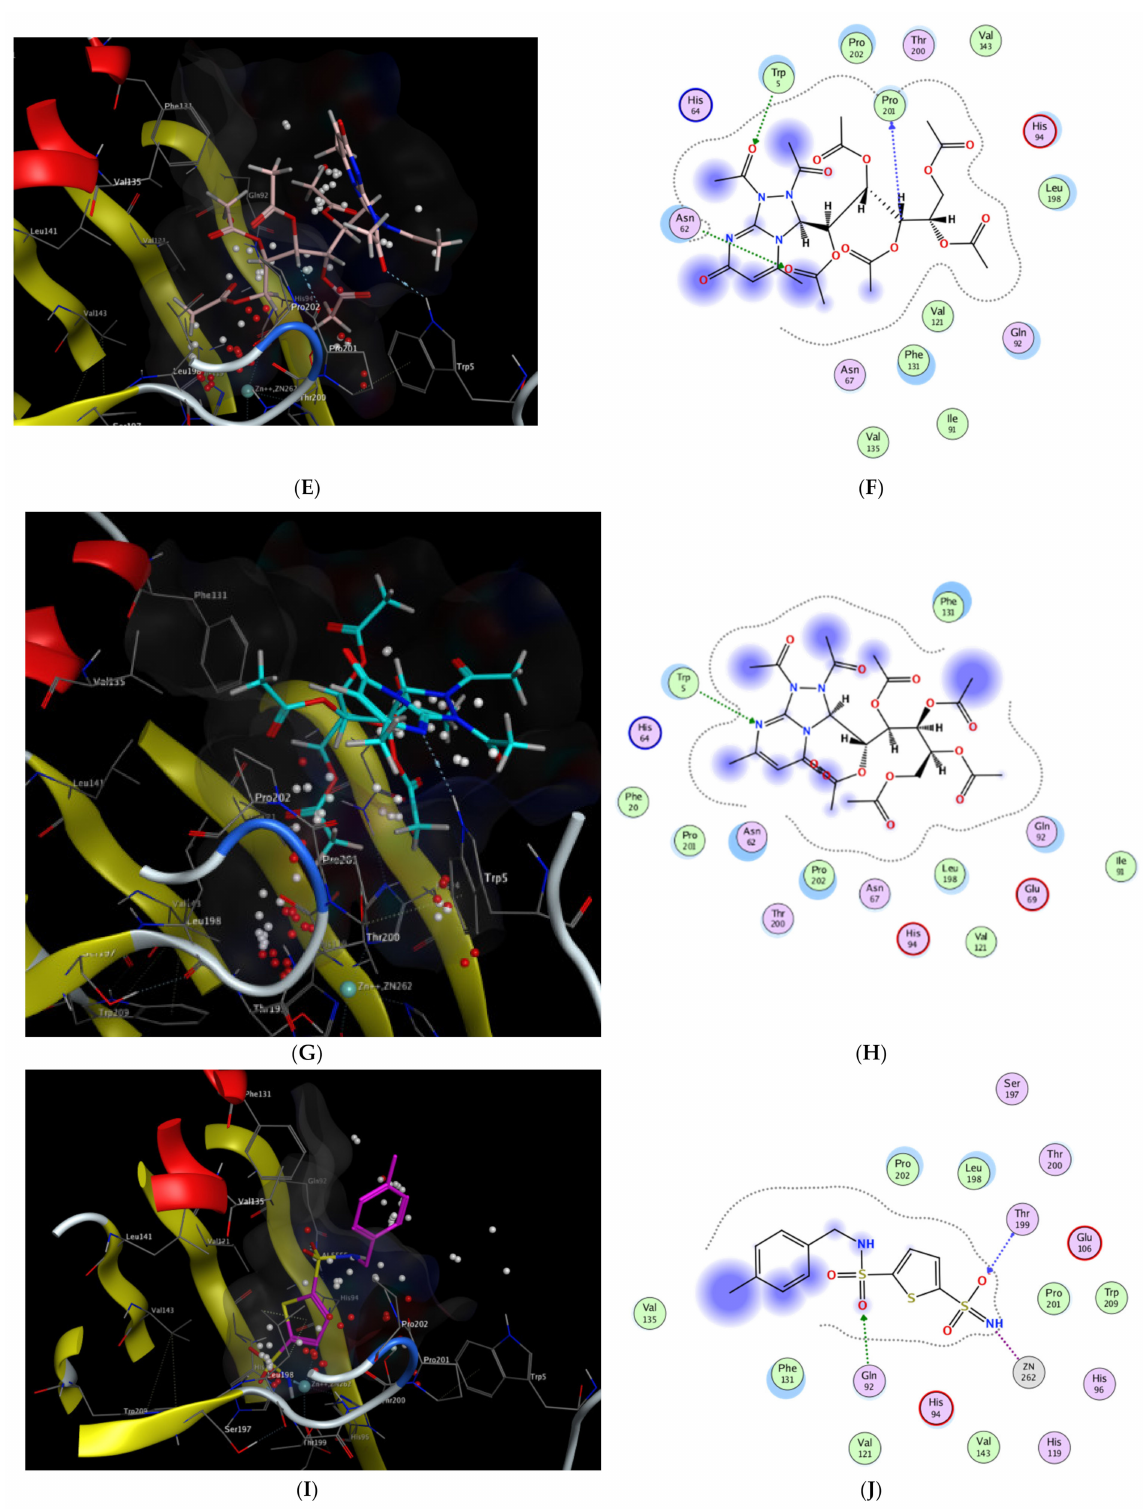
Figure 6. ( A ) The 3D binding mode of 8A (yellow sticks), ( B ) 2D binding mode of 8A , ( C ) 3D binding mode of 8B (green sticks), ( D ) 2D binding mode of 8B , ( E ) 3D binding mode of 9A (pink sticks), ( F ) 2D binding mode of 9A , ( G ) 3D binding mode of 9B (cyan sticks), ( H ) 2D binding mode of 9B , ( I ) 3D binding mode of the co-crystallized CA II inhibitor AL5 (magenta sticks), and ( J ) 2D binding mode of AL5 in the active site of CA II (PDB ID:1BN1